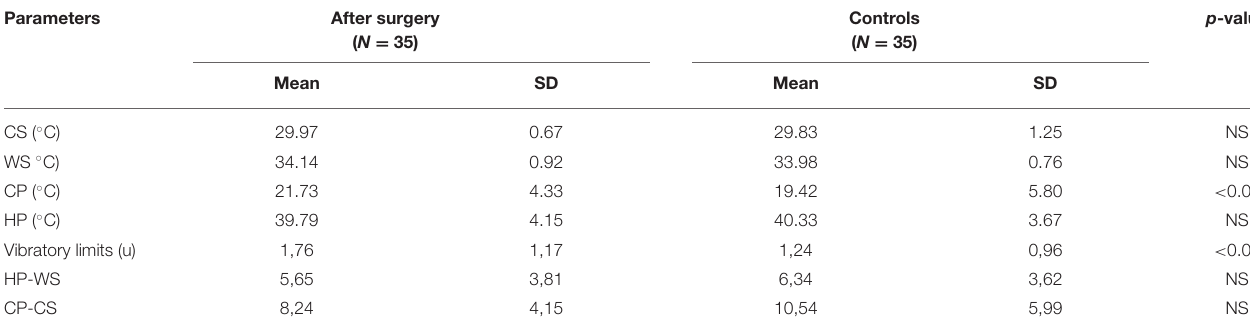
TABLE 3B | Mean values of QST after surgery in CTS patients and in the control group. Parameters